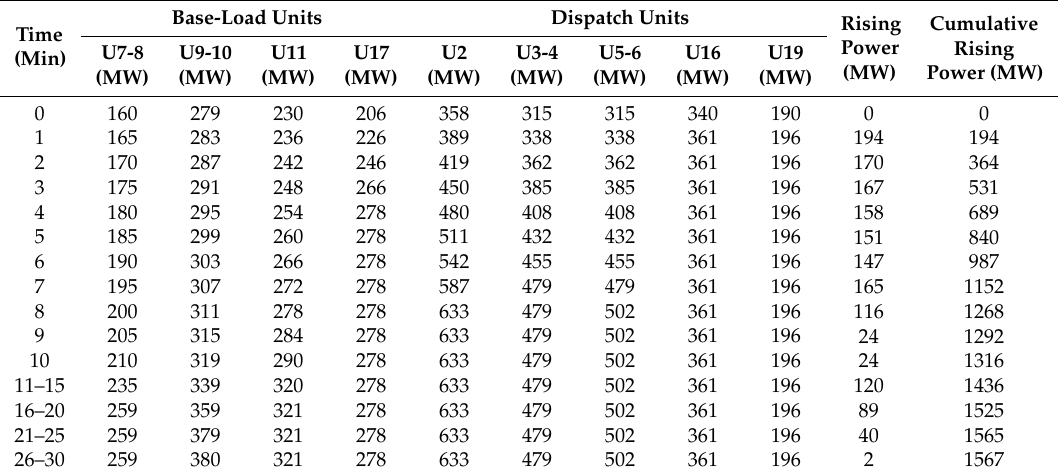
Table 5. The UC problem solved using the SA to increase power output by 1560 MW within 30